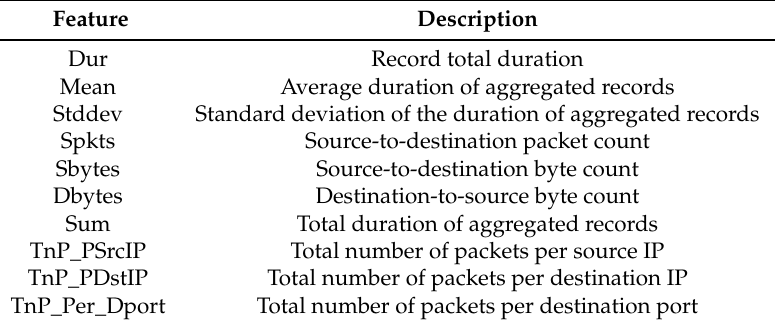
Table 1. Flow feature